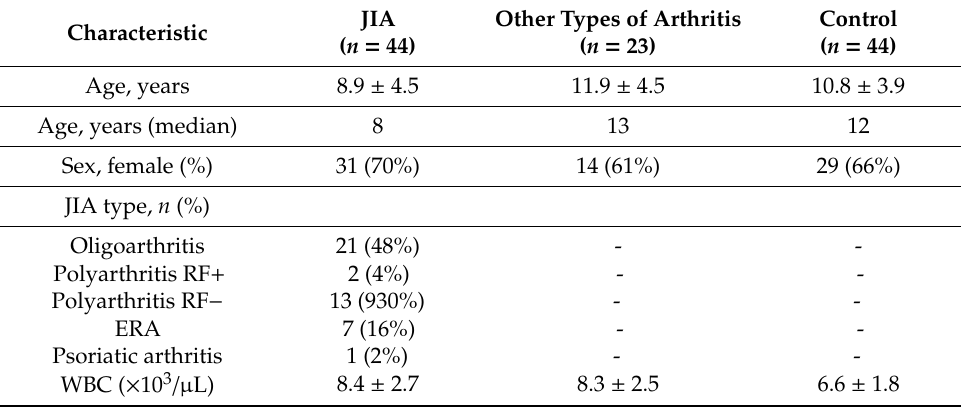
Table 1. Baseline demographic and clinical characteristics of the